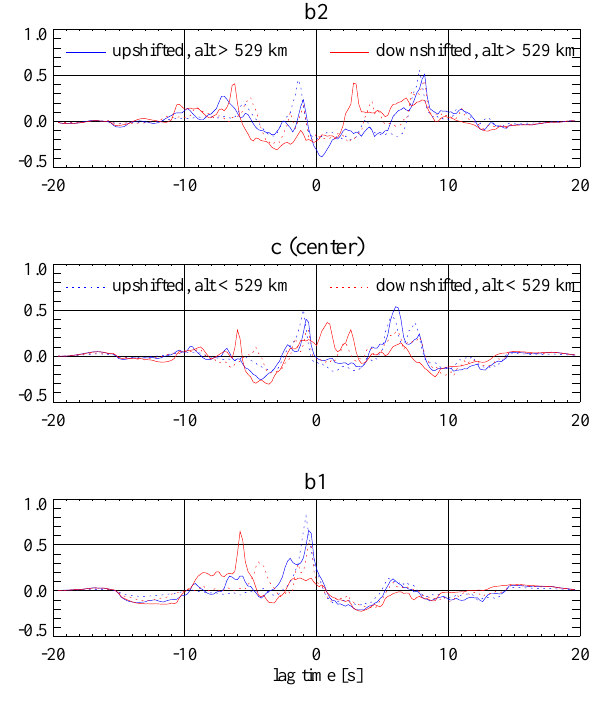
Fig. 14. Cross-correlation between the time series extracted from the radar (for the blue solid line the radar time series is maximum power in the upshifted shoulder above 529km altitude) and the cam- era (the camera time series are normalised light intensity drawn from the one of three regions; b1, c, b2, along line b in Fig. 5). The upper panel shows the cross-correlation between the radar time series and the normalised light intensity from region b2. The mid- dle and lower panels are similar, but the normalised light intensities are taken from the center of the radar beam (region c), and 25 pixels below it (region b1), respectively. Positive lag times correspond to events appearing first in the radar